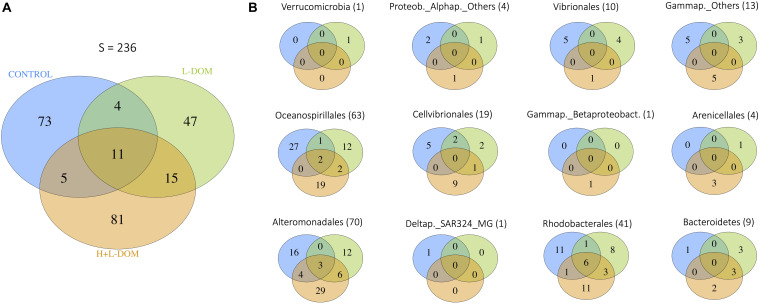
Venn diagrams showing (A) the number of ASVs shared among the CONTROL, H + L-DOM and L-DOM treatments, as well as unique ASVs for each treatment, for the whole bacterial community; and (B) the number of ASVs shared among CONTROL, H + L-DOM and L-DOM, as well as unique ASVs for each treatment, for specific bacterial Orders. In brackets, the total number of ASVs belonging to each Order is shown. See Table 1 for treatments definition.